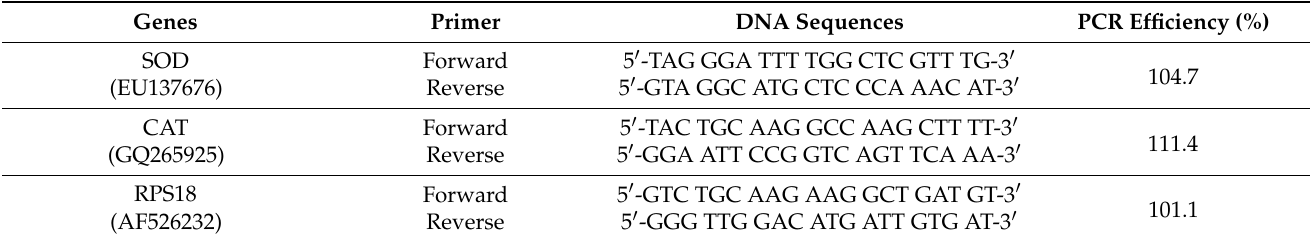
Table 1. Primers used for qPCR and in situ hybridization. Primer DNA